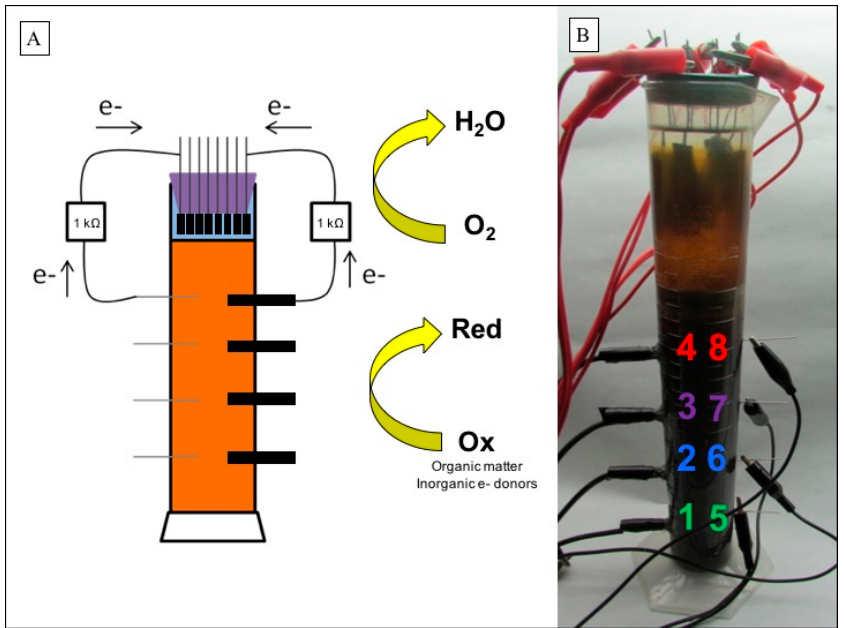
Figure 1. Sampling site located in the upper section of Lluta River (Arica and Parinacota Region) in northern Chile (17°43 ′ 12 ″ S and 69°49 ′ 18 ″ W).